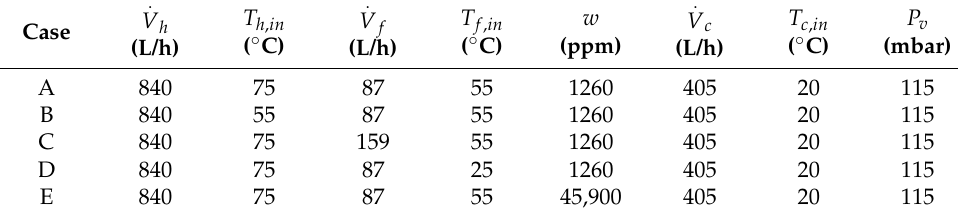
Table 5. Several scenarios of input conditions considered for the exergy analysis.